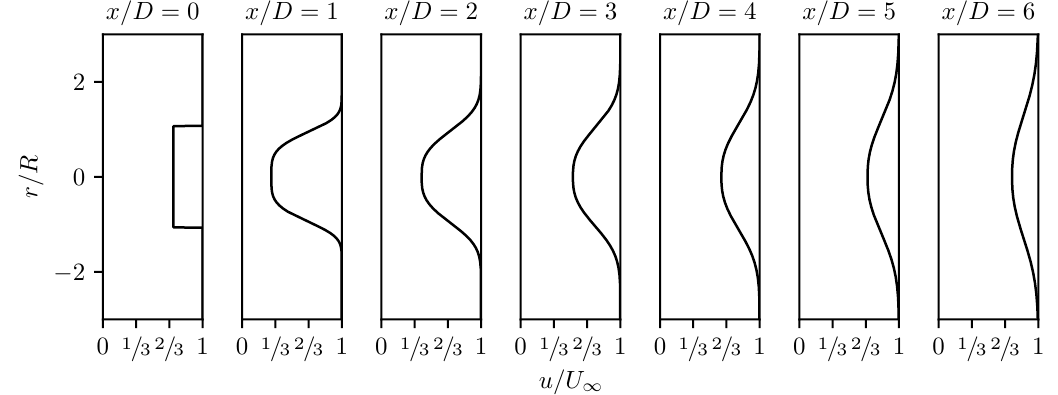
Figure 1. Profiles of streamwise velocity u ( x , r ) at various downstream distances based on the wake profile function W ( x ) in